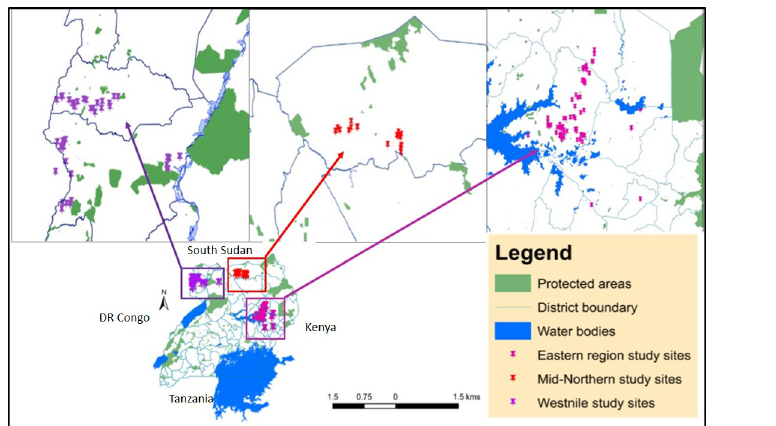
Fig 1. Map of Uganda showing the distribution of study sites Northern Uganda (West Nile, mid-northern and Eastern). The base map of protected areas was downloaded from world resource institute website [21].